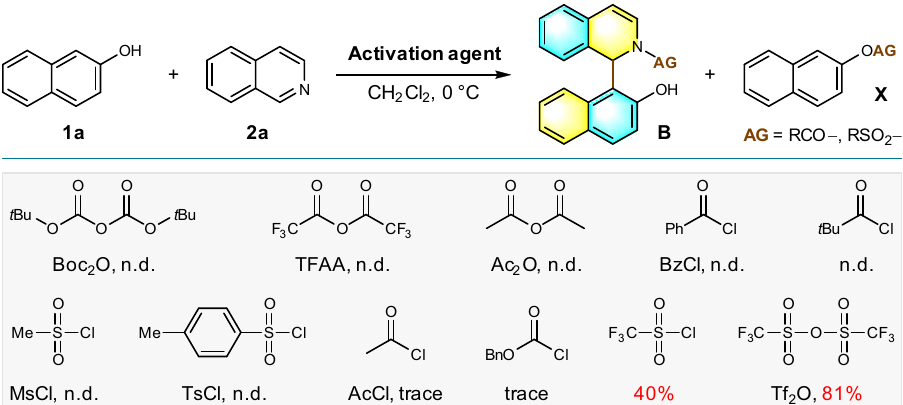
Fig. 2 Initial screening of activation agents. Conditions: acylation agent (0.5 mmol) and 2a (1.25 mmol) were stirred in CH 2 Cl 2 (4 mL) for 0.5 h at 0 °C. The solution of 1a (0.50 mmol) in CH 2 Cl 2 (4 mL) was then added and stirred for another 2 h. Isolated yield